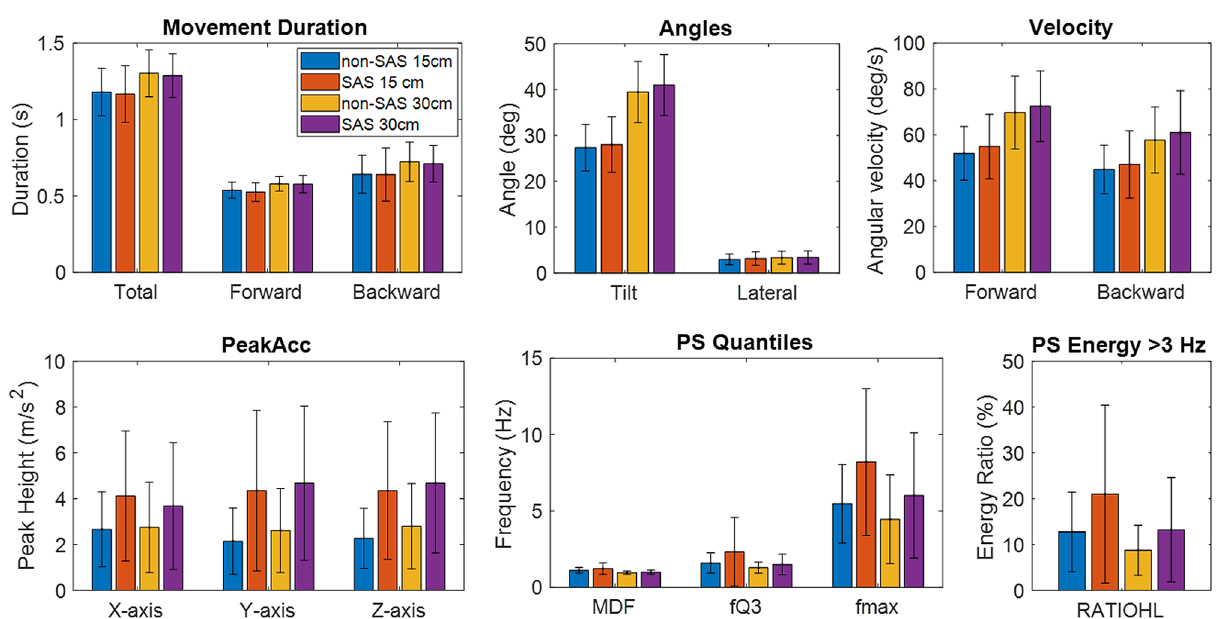
Figure 6. Barplots showing the mean and standard deviation of all the parameters extracted from the smartphone accelerometer, for the two distances (15 cm vs 30 cm) and conditions (SAS vs